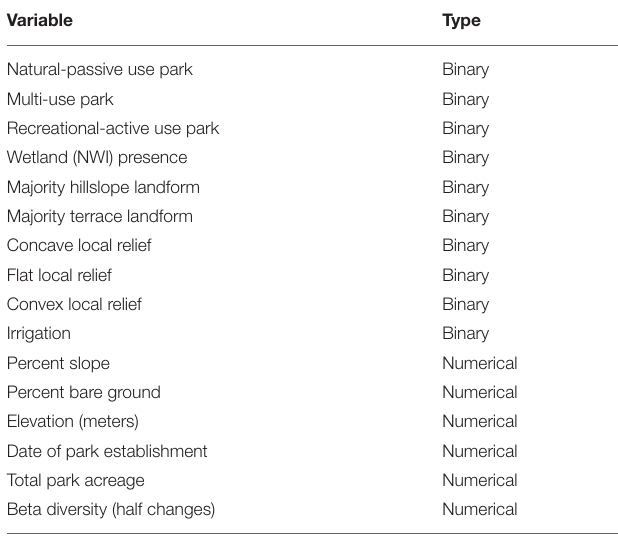
TABLE 1 | Environmental variables, including habitat, and park